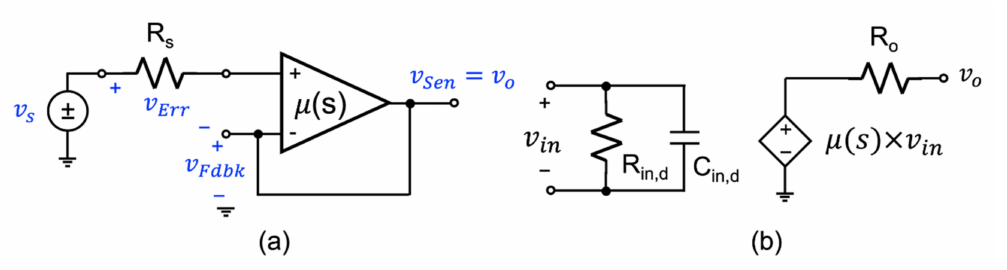
Figure 9. Voltage-mixing/voltage-sensing topology: ( a ) Unity-gain amplifier using an op-amp, and ( b ) op-amp circuit model with general gain function µ (s). The voltage-mixing signal are highlighted in